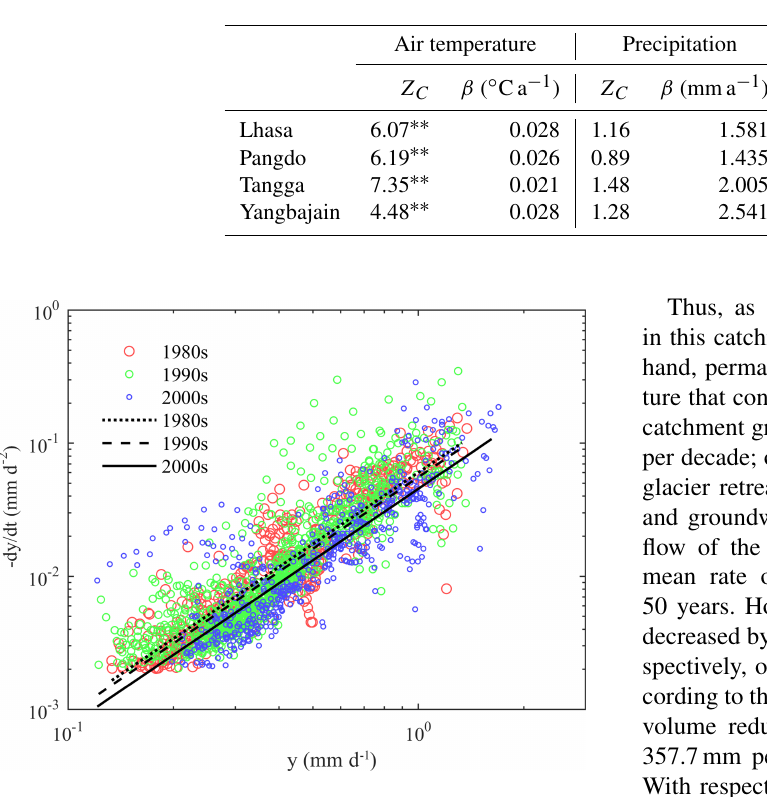
Figure 8. Recession data points of − d y/ d t versus y as well as the fitted recession curves by decade in log–log space. The black dotted line, the dashed line and the solid line represent the recession curves in the 1980s, 1990s and 2000s,